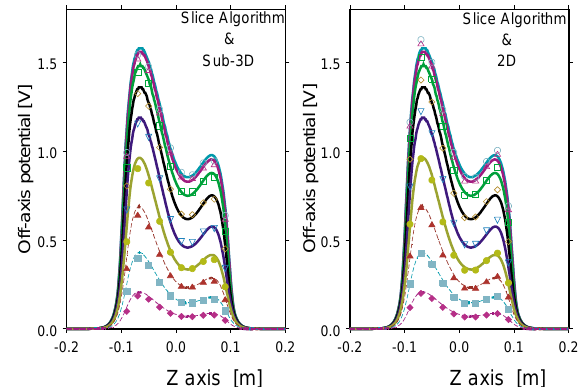
FIG. 8. (Color) On the left-hand side is the longitudinal potential of the beam bunch of Fig. 1 inside a metal pipe of radius 2 cm calculated by the slice algorithm of Sec. II (solid and dashed lines) and the sub-3D Poisson solver (symbols) for 0 # r # 2 cm. On the right-hand side are the results of the sub-3D Poisson solver approach (symbols), but neglecting the ≠ 2 u (cid:3) ≠ z 2 correction term.